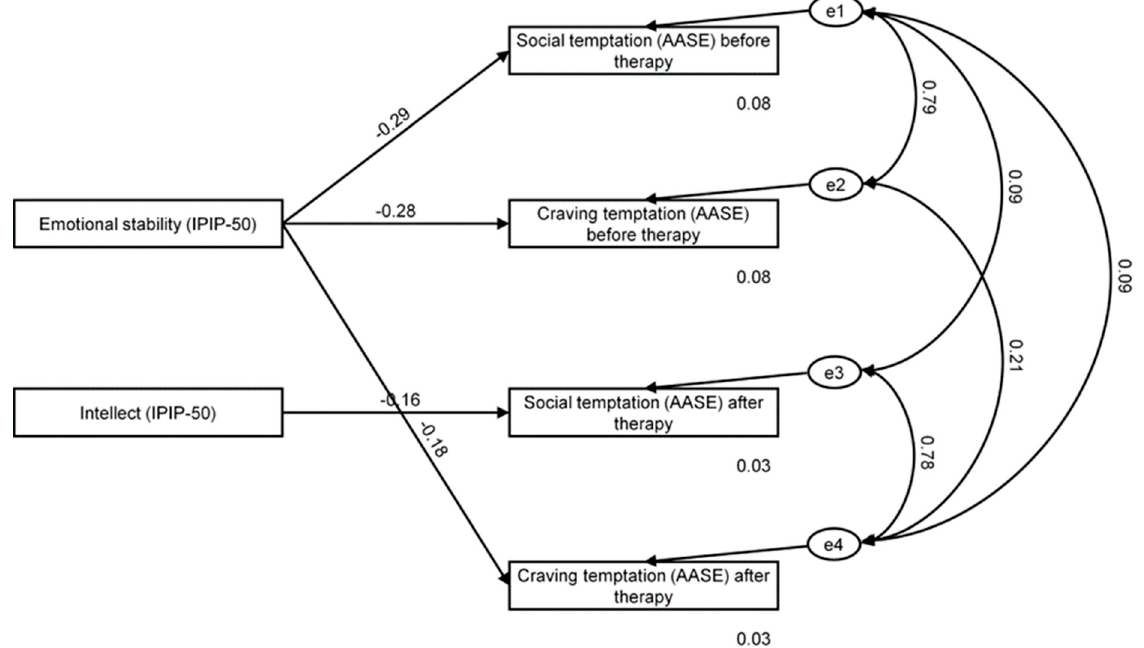
Figure 2. Emotional stability and intellect as predictors of self-efficacy in the investigated group before and after therapy. e1–e4 depict the error term referring to the dependent variables.